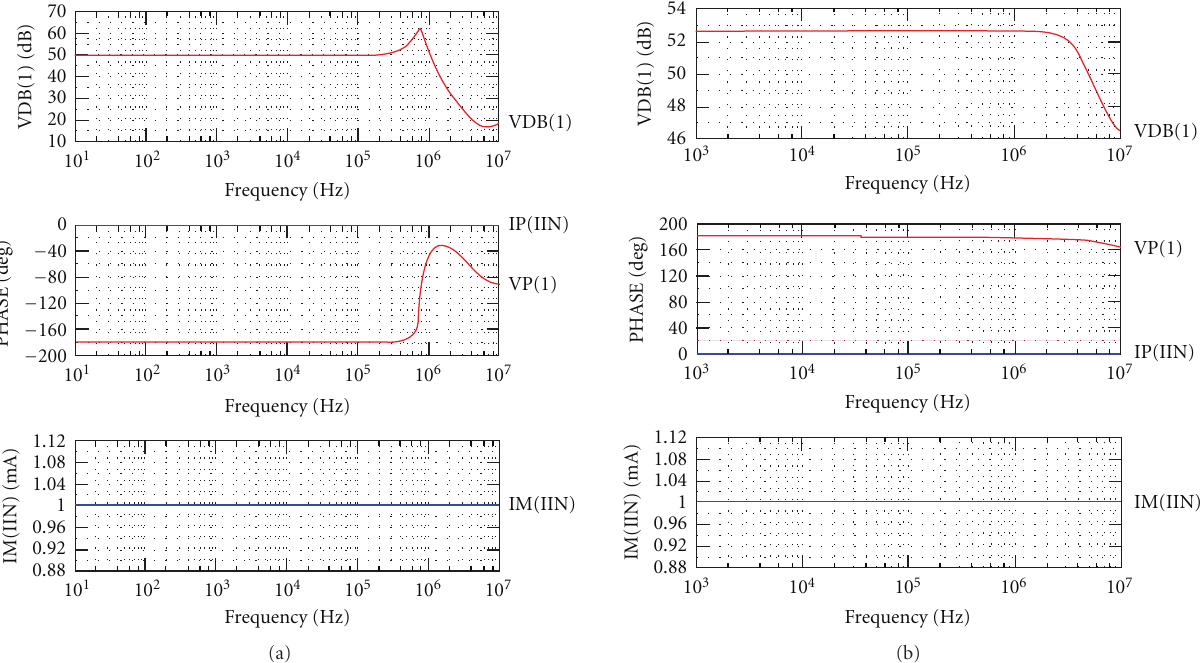
Figure 7: (a) Frequency response of the FDNR realization 1 in Table 2. (b) Frequency response of the FDNR realization 8 in Table